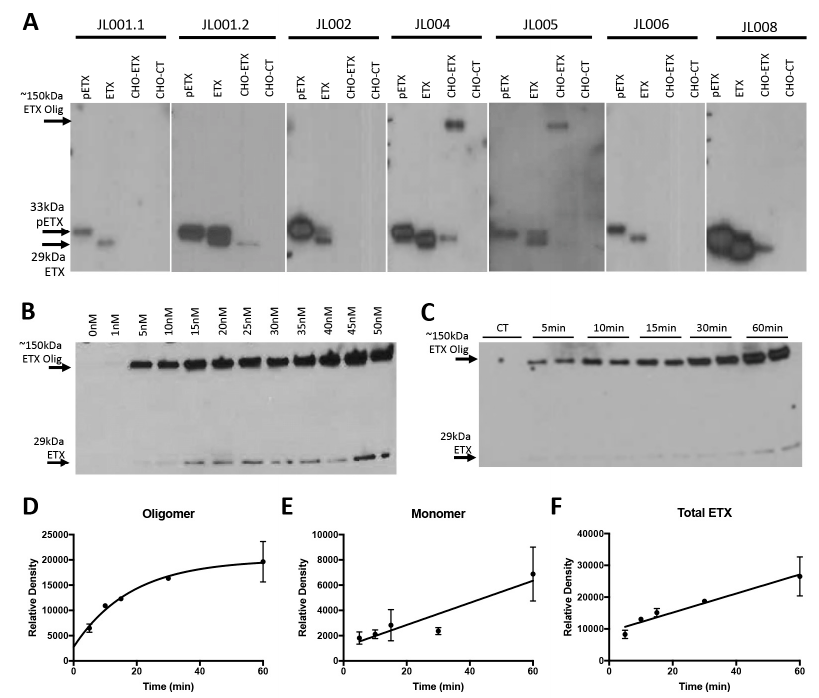
Figure 2. Detection of pETX, ETX, and ETX-oligomer via western blot analysis. ( A ) 5 ng of ETX and pETX were loaded onto gels. To detect ETX-pore, whole-cell lysates from rMAL-CHO cells (CHO-ETX) were used. Whole-cell lysates from untreated rMAL-CHO cells (CHO-CT) were used as a negative control. Antibodies JL001.1 and JL006 only detected purified pETX and ETX. JL1001.2 and JL008 were able to detect pETX and ETX, as well as bound ETX monomer of treated rMAL-CHO cells. JL005 was able to detect pETX and ETX as well as the ETX-oligomer. JL004 was able to pETX, ETX, ETX